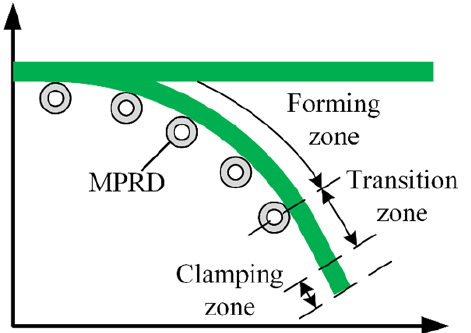
Figure 8. Definition of transition zone length.